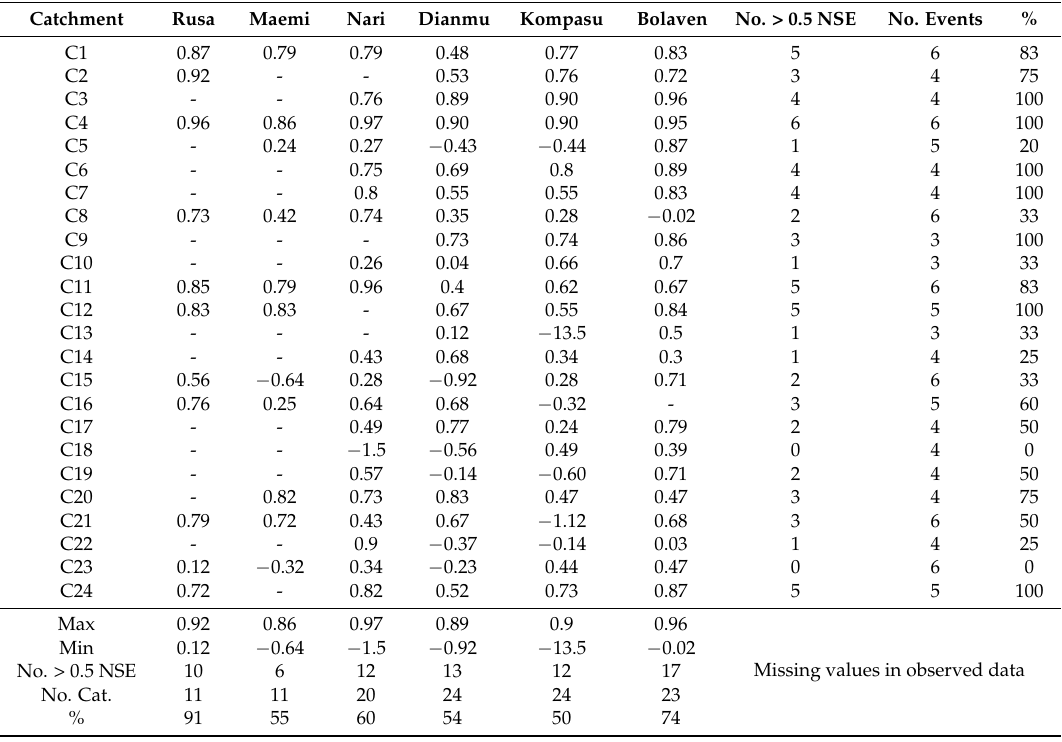
Table 6. Calibration Results (NSE) for the six typhoon flood events for all 24 catchments